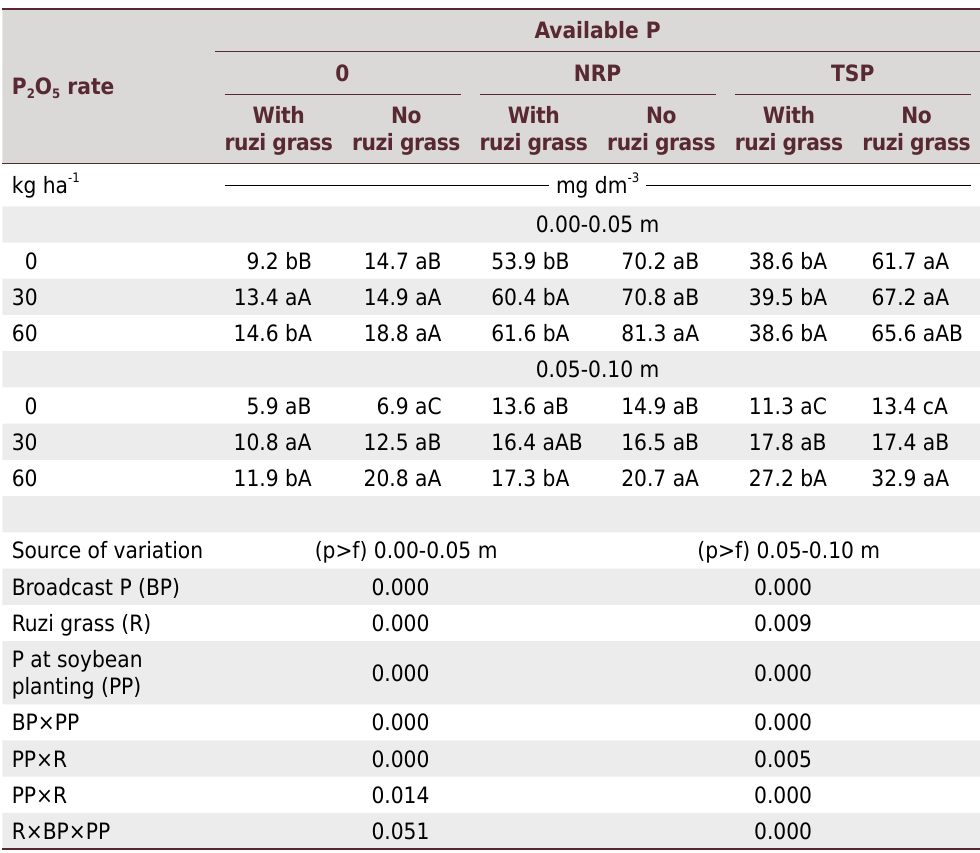
Table 1. Available P (resin) at soybean planting and P values (p>f) at soil depths of 0.00-0.05 and 0.05-0.10 m, as affected by phosphates (soluble and reactive) broadcast in the presence or absence of ruzi grass and P rates applied to soybean seed furrows (0, 30, and 60 kg ha -1 of P 2 O 5 as TSP). November 2010